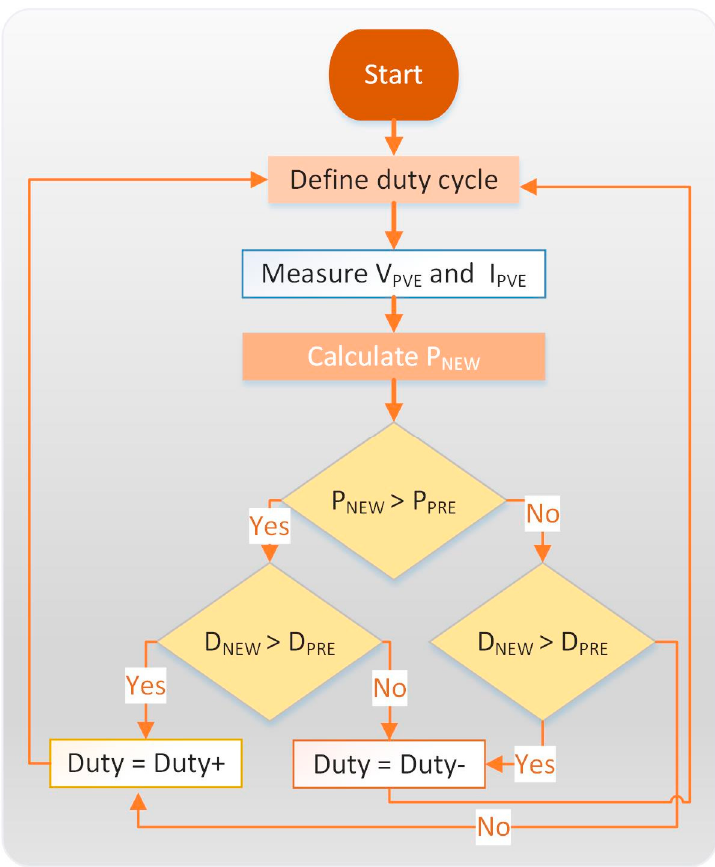
Figure 10. Perturb and observe (P&O) control algorithm.